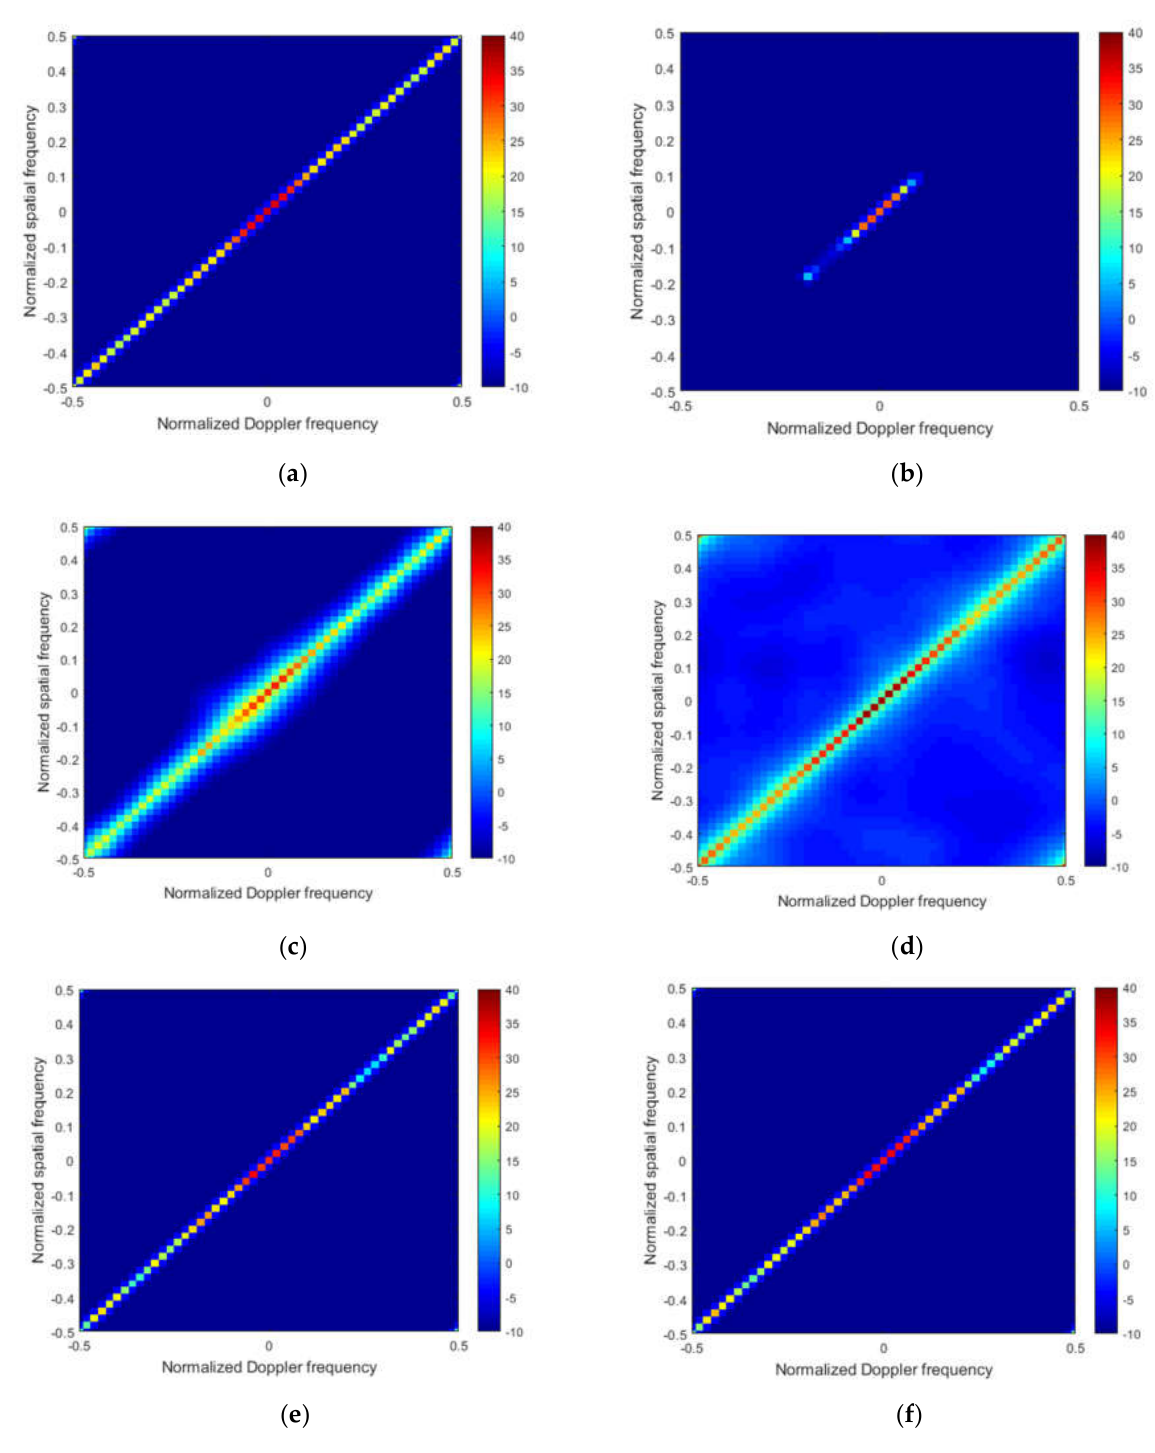
Figure 4. Capon spectrum of different methods without error. ( a ) The ideal capon spectrum; ( b ) the capon spectrum of M-OMP; ( c ) the capon spectrum of M-FOCUSS; ( d ) the capon spectrum of M-IAA; ( e ) the capon spectrum of M-SBL; ( f ) the capon spectrum of proposed method.